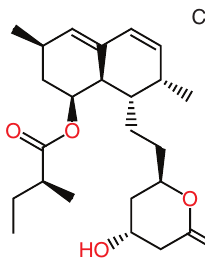
Table 4 (a,b). Lovastatin-lactone (a) v. lovastatin- hydroxyacid (b) metrics across the top two modeled receptor sites. AutoDock4.1Score is a weighted sum of steric interactions (Gauss 1, Gauss 2, and steric), repulsion, hydrophobic interaction between hydrophobic atoms, and, where applicable, hydrogen bonding 26 .